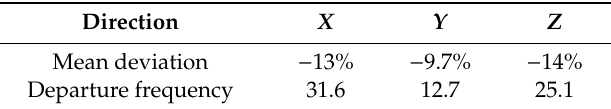
Table2. ThemeandeviationbetweentheSOAmodelandtheBornapproximationbelowbreakfrequency (SOA model is treated as the reference) and the break frequency k L a X of the Born approximation for a Table 2. The mean deviation between the SOA model and the Born approximation below break textured polycrystal with ellipsoidal Ti frequency (SOA model is treated as the reference) and the break frequency 𝑘 (cid:3013) 𝑎 (cid:3025) of the Born approximation for a textured polycrystal with ellipsoidal Ti grains.